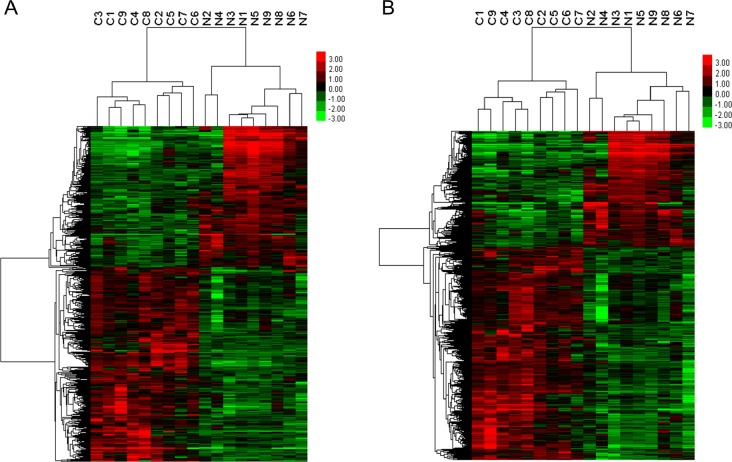
Hierarchical clustering of aberrant expressed lncRNAs and mRNAs detected in advanced LSCC.Red color indicates over expression and green color indicates low expression. Every column represents a tissue sample and every row represents an lncRNA/mRNA probe. C represents cancer tissues and N represents adjacent normal tissues. (A) lncRNA hierarchical clustering. (B) mRNA hierarchical clustering.